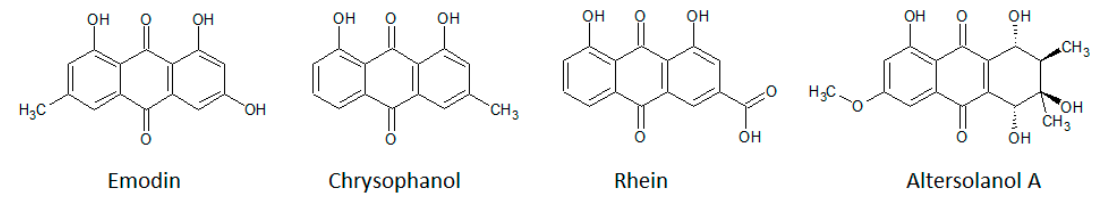
Figure 5. Structures of some anthraquinone derivatives.